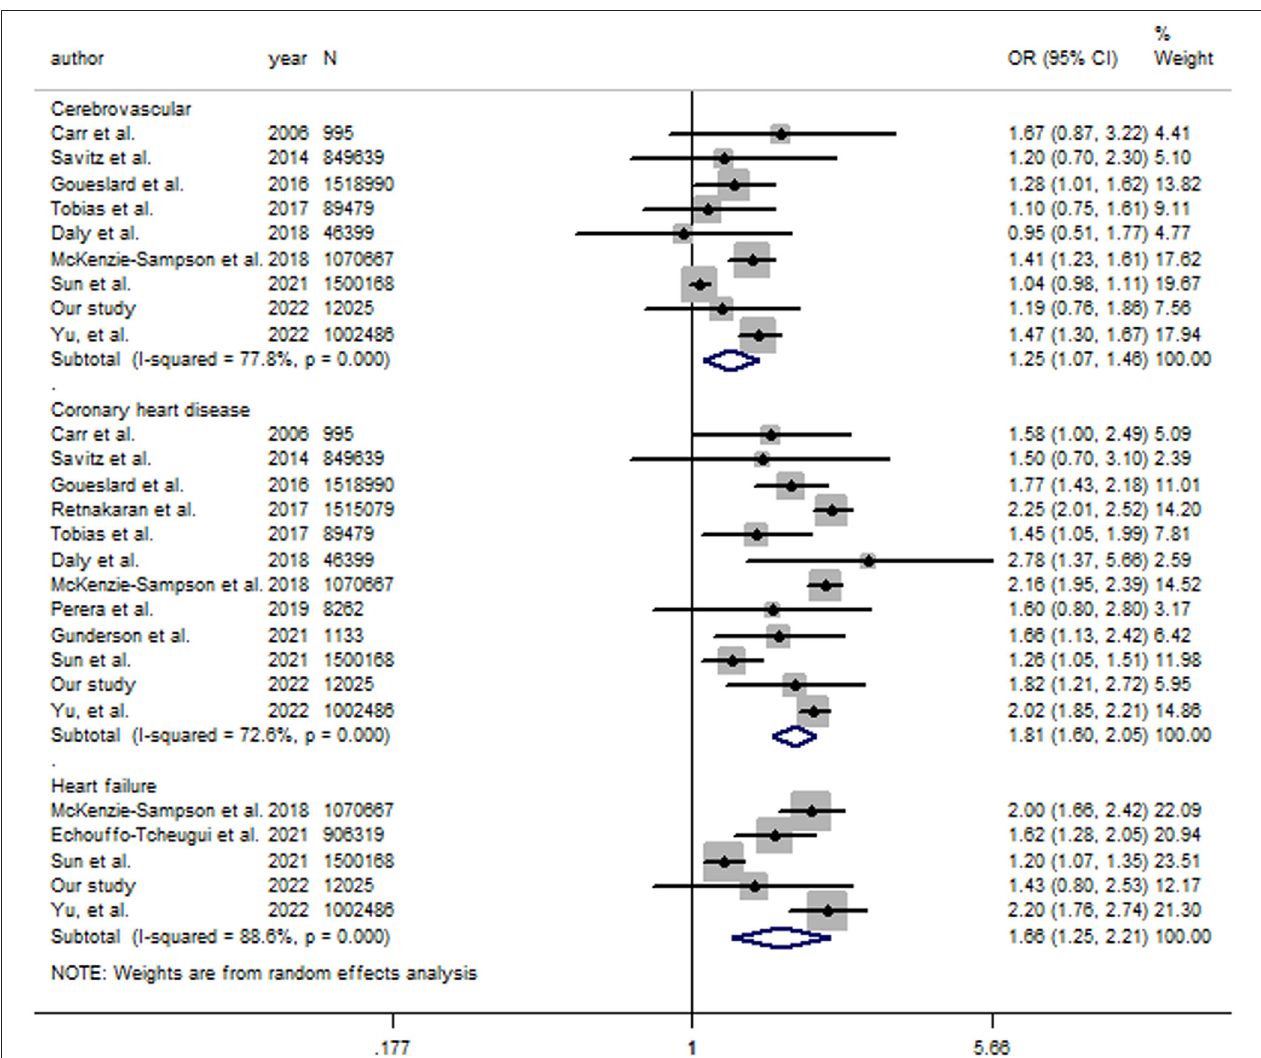
FIGURE 1 | The forest plot for gestational diabetes mellitus and risks of coronary heart disease, heart failure and cerebrovascular disease. The size of gray box is positively proportional to the weight assigned to each study, which is inversely proportional to the standard error of the OR, and horizontal lines represent the 95 % confidence intervals. OR (95% CI): Odds ratio (95% confidence